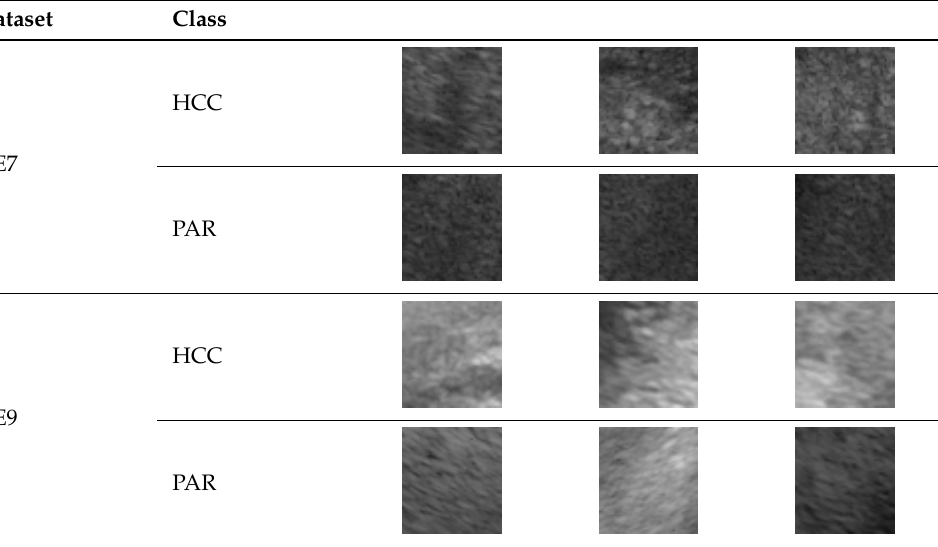
Table 1. Relevant examples from the two considered datasets GE7 and GE9.